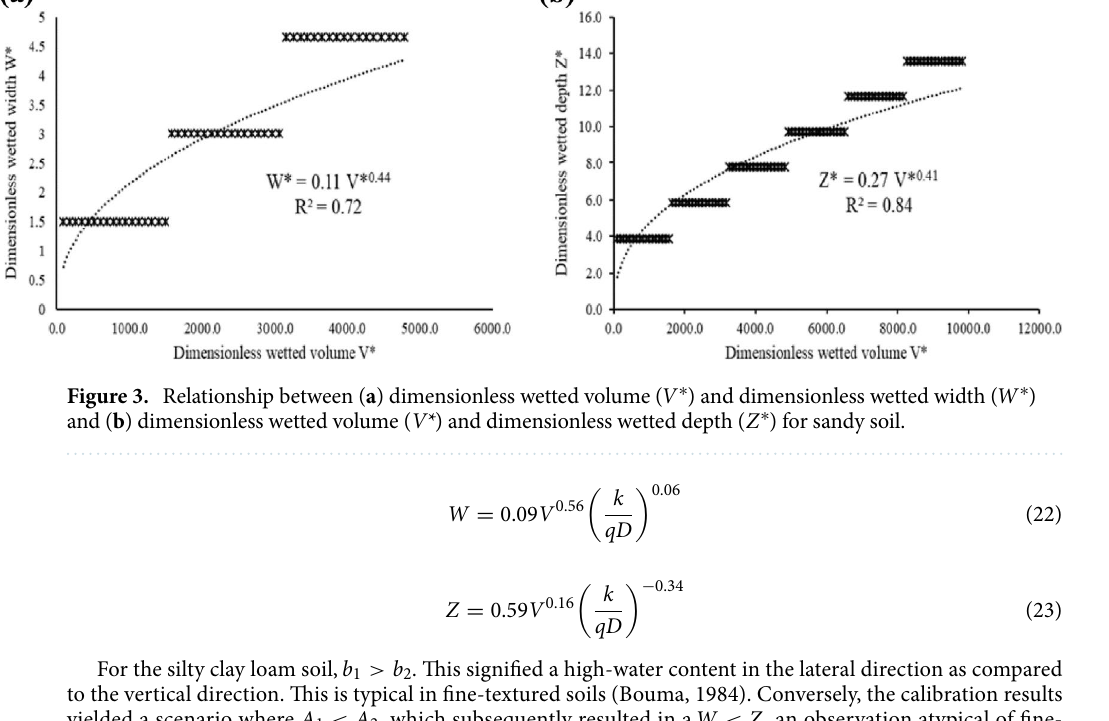
textured soils. This was because the application times during the experiment promoted the border effect within the confined soil bin. Sandy soil. The simulation steps for the sandy soil followed similar steps as those described for the silty clay loam soil. The relationships between the dimensionless volumetric soil water content per unit length of MTI ( V ∗ ) and the dimensionless wetted width ( W ∗ ) and wetted depth ( Z ∗ ) are depicted in Fig. 3. The resultant wetted width ( W ) and wetted depth ( Z ) for the soil are shown in Eqs. (21) and (22). W ∗ was plotted against V ∗ , similarly Z ∗ was plotted against V ∗ and the resulting power relationships yielded Eqs. (24) and (25) with R 2 = 0.72 and R 2 = 0.84, respectively (see Fig. 3).